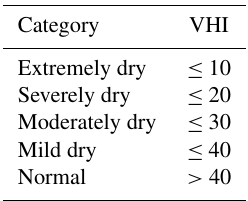
Table 4. Drought classification based on VHI according to Dalezios et al.